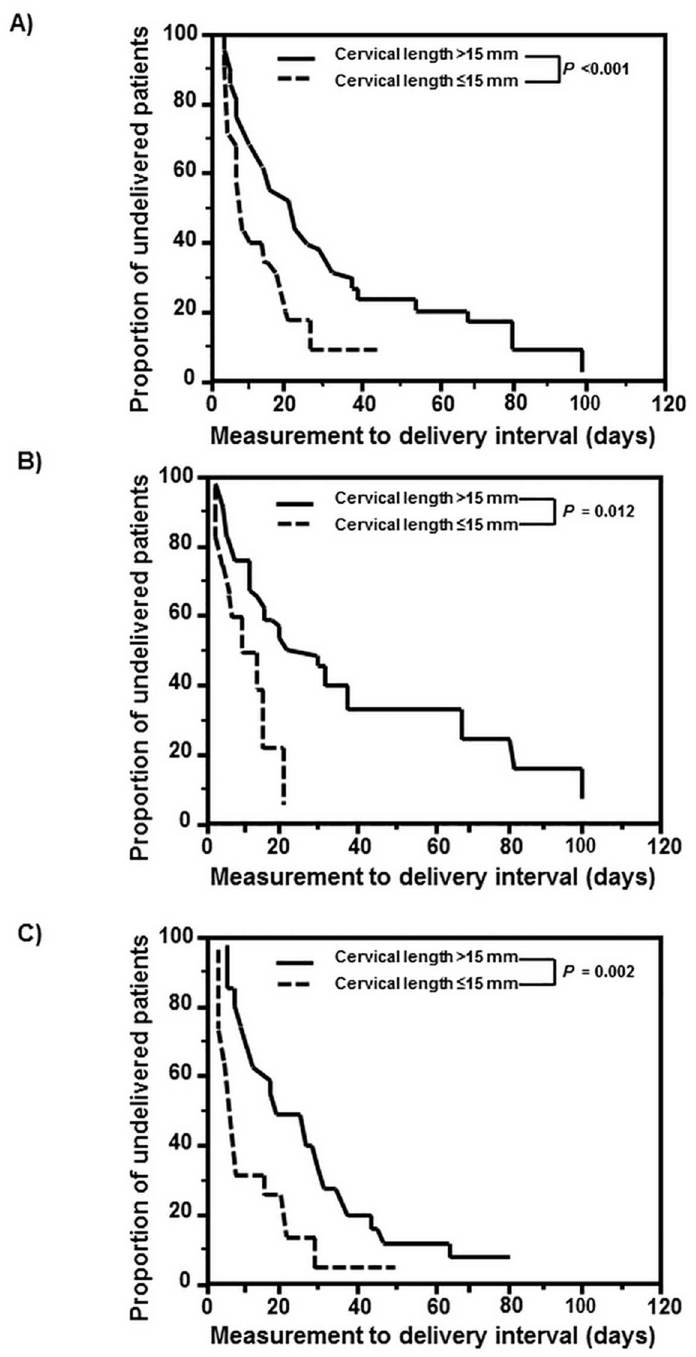
Fig 3. Kaplan-Meier estimates of measurement-to-delivery interval according to the results of cervical length assessedby ultrasound (using 15 mm as cut-off) in (A) total study population (median, 4.08 days [95% CI, 2.59–5.58] vs. 19.29 days [95% CI, 11.24–27.35]; P < 0.001), (B) women without intra- amniotic infection/inflammation (median, 6.83 days [95% CI, 0.00–15.21] vs. 18.54 days [95% CI, 1.96– 35.13]; P = 0.012), and (C) women with intra-amniotic infection/inflammation (median, 3.25 days [95% CI, 1.78–4.72] vs. 19.79 days [95% CI, 9.04–30.55]; P = 0.002).